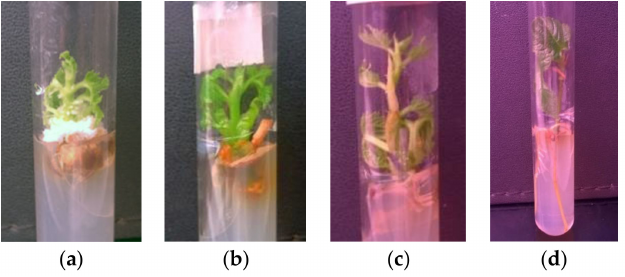
Figure 4. Initiation of in vitro shoot cultures of mountain mulberry ‘Kenmochi’ on cytokinin-containing (“AxB”) and cytokinin-free (“SNC”) media ( a – d , respectively). Note growth of callus on “AxB” medium and emergence of roots on “SNC”